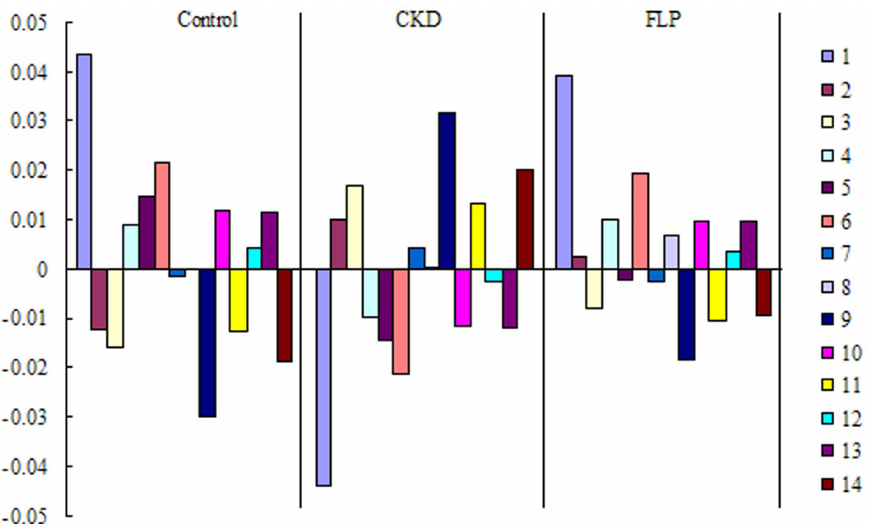
Figure 7. Correlation coefficient analysis between groups with corresponding markers in different groups. Variables are presented in control, CKD and FLP groups. Values of correlations are shown in the vertical axis (upper for positive correlations and low for negative correlations) and corresponding markers represented to the right of the bars. Numbers are consistent with Table 1.